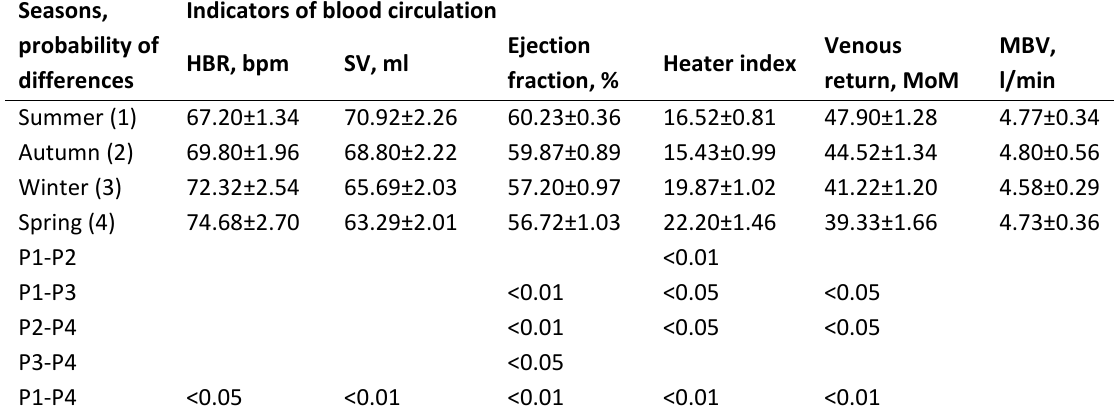
Table 4. Indicators of students’ central haemo-dynamic in different seasons Seasons, probability